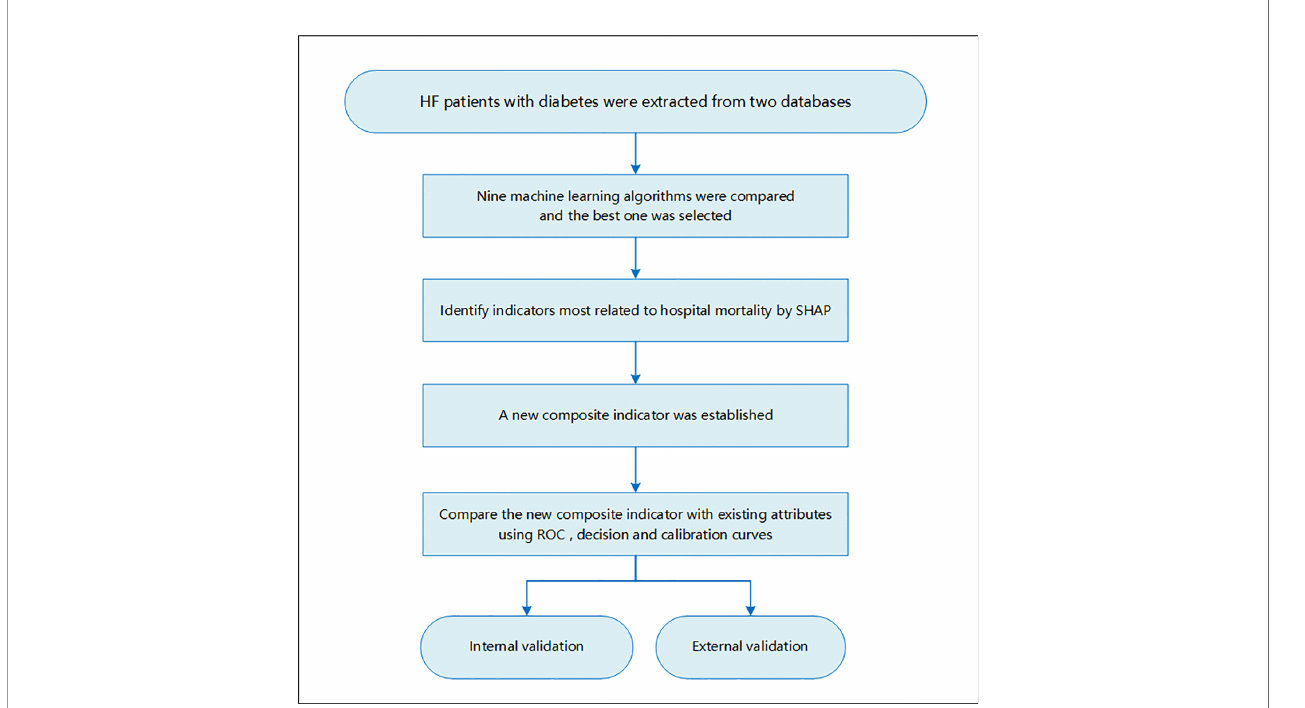
FIGURE 1 | Flowchart of this